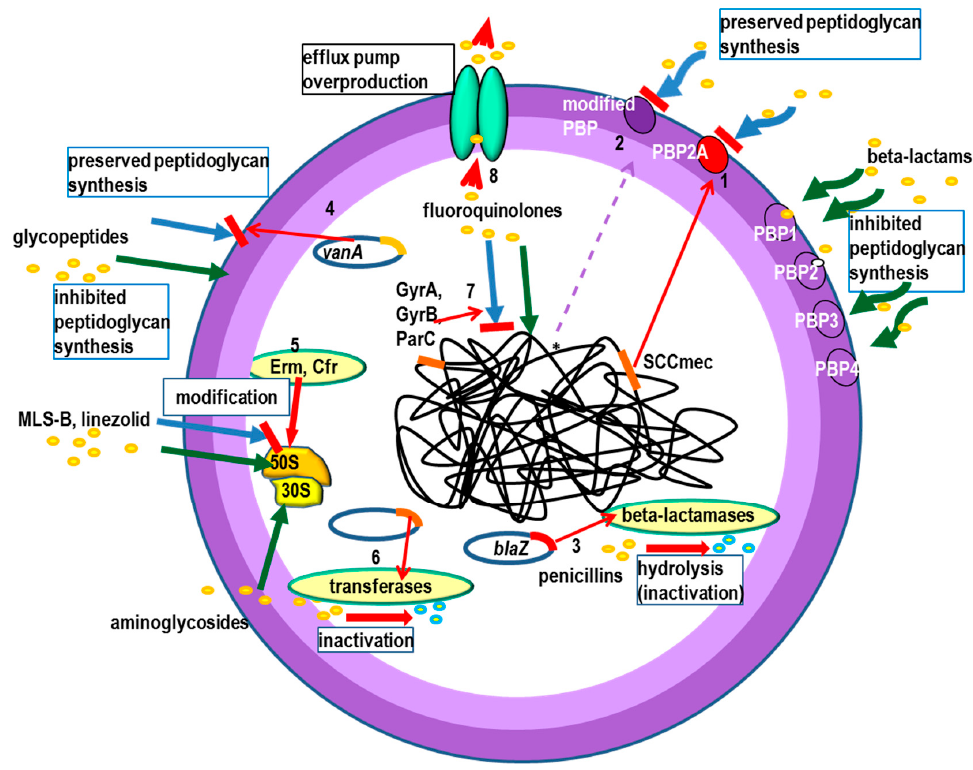
Figure 1. The most important resistance mechanisms in Staphylococcus aureus : antibiotics , mechanisms of action—green arrows. Resistance to beta lactams: 1. Production of penicillin-binding protein PBP2A, 2. * mutations in PBP genes—rare (MODSA), 3. beta-lactamases production -usually narrow substrate spectrum. Glycopeptide resistance: 4. VanA operon (modification of the antibiotic binding site), Linezolid resistance: 5. adenylyl-N-methyltransferase Cfr-modification 23S rRNA of bacterial ribosome. Resistance to MLS-B (macrolides, lincosamides and streptogramins B): 5. Erm—erythromycin ribosome methylation. Aminoglycosides resistance: 6. antibiotics inactivation by tansferases. Fluoroinolones resistance: 7. mutations in gyrA and gyrB (topoisomerase II) and parC ( grlA ) and parE (topoisomerase IV) genes (modification of the antibiotic binding site), 8. removal from the bacterial cell by the efflux pump.